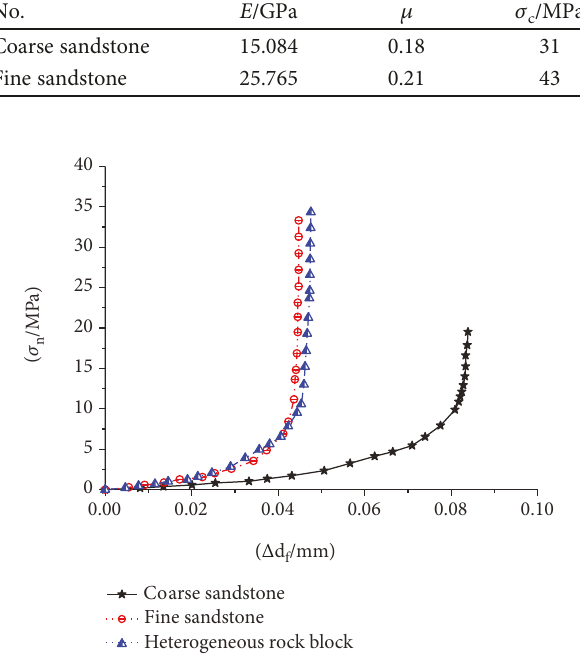
Figure 6: Normal deformation of fi ssure